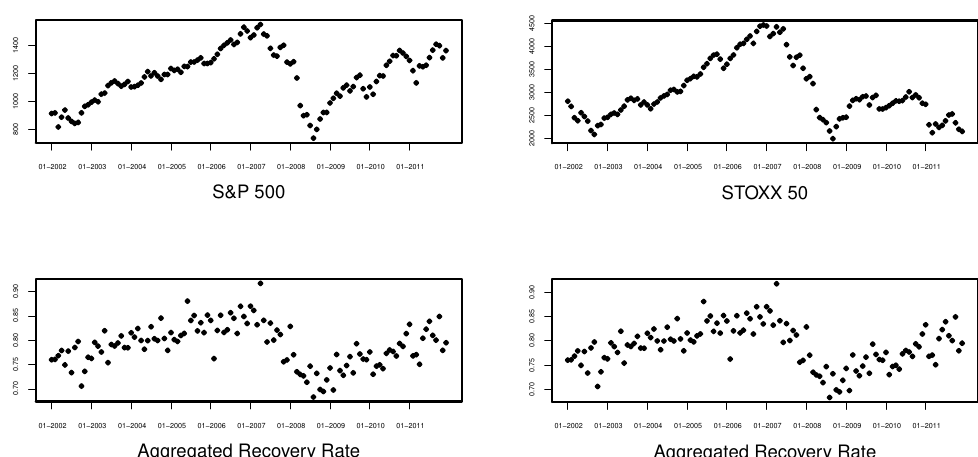
Figure 7. Shifted S&P500 ( top left ) and STOXX 50 ( top right ) vs. recovery rate ( bottom ).